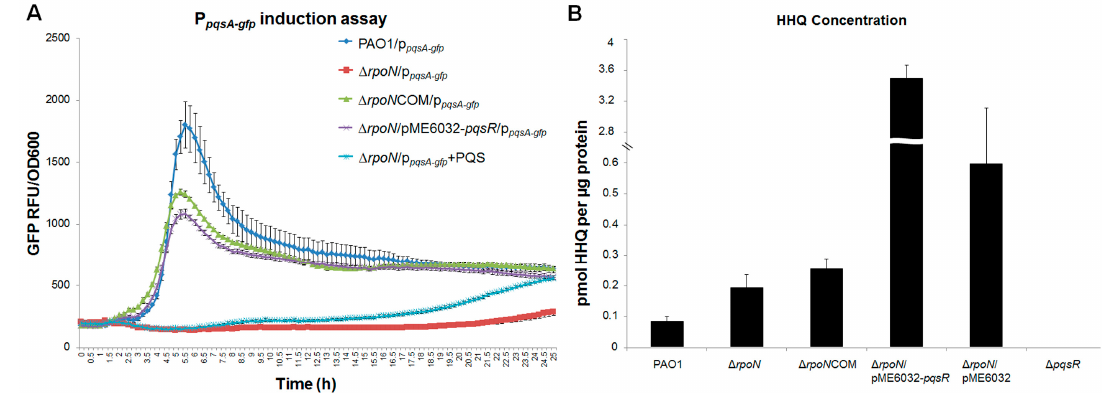
Figure 1. Regulation of pqs quorum sensing by RpoN. ( A ) Induction of p pqsA- gfp transcriptional fusion in PAO1 wild-type, Δ rpoN , Δ rpoN COM, Δ rpoN /pME6032 -pqsR and Δ rpoN + PQS (2-heptyl-3-hydroxy-4(1H)-quinolone). Cultures were monitored for their gfp fluorescent protein (GFP) fluorescence by using a Magellen Tecan ® Infinite 200 PRO microplate reader. Means and standard deviations (S.D.) in relative fluorescence units (RFU) from triplicate experiments are shown; ( B ) High-performance liquid chromatography (HPLC) analysis of HHQ (4-hydroxy-2-heptylquinoline) production by PAO1, Δ rpoN , Δ rpoN COM, Δ rpoN /pME6032 -pqsR , Δ rpoN /pME6032 and Δ pqsR. Means and S.D. from triplicate experiments are shown.